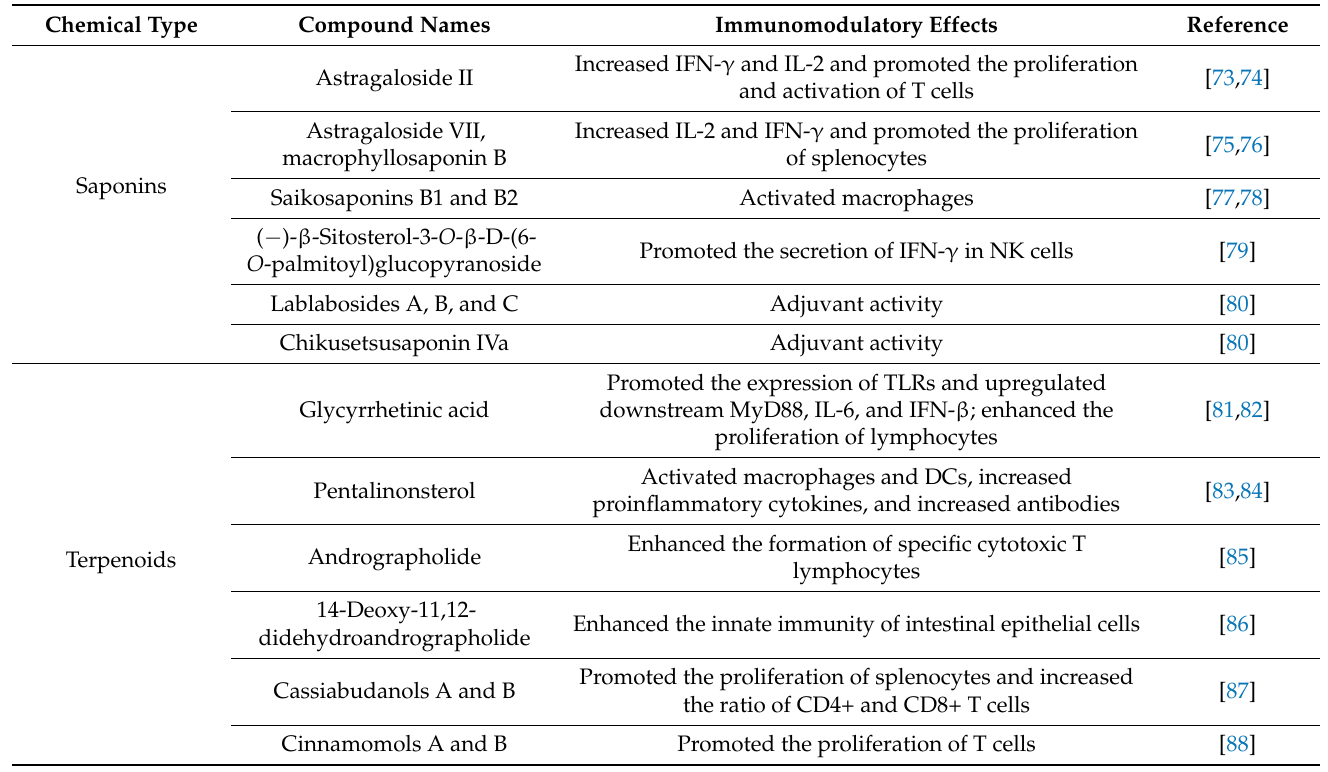
Table 2. Small molecules that enhance